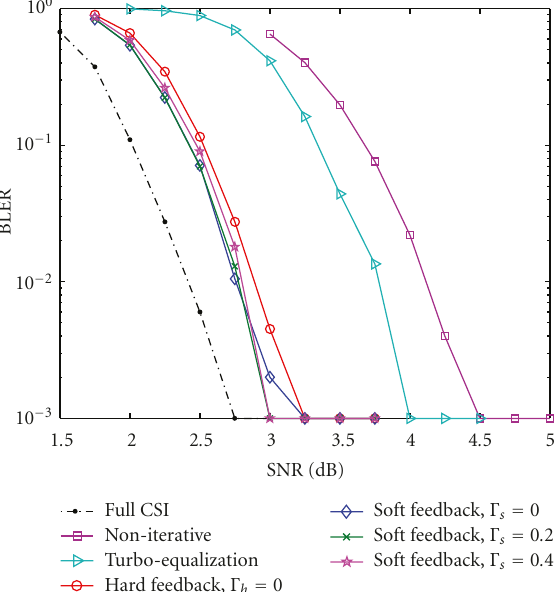
Figure 6: Simulation results, N t = 3, N r = 6,